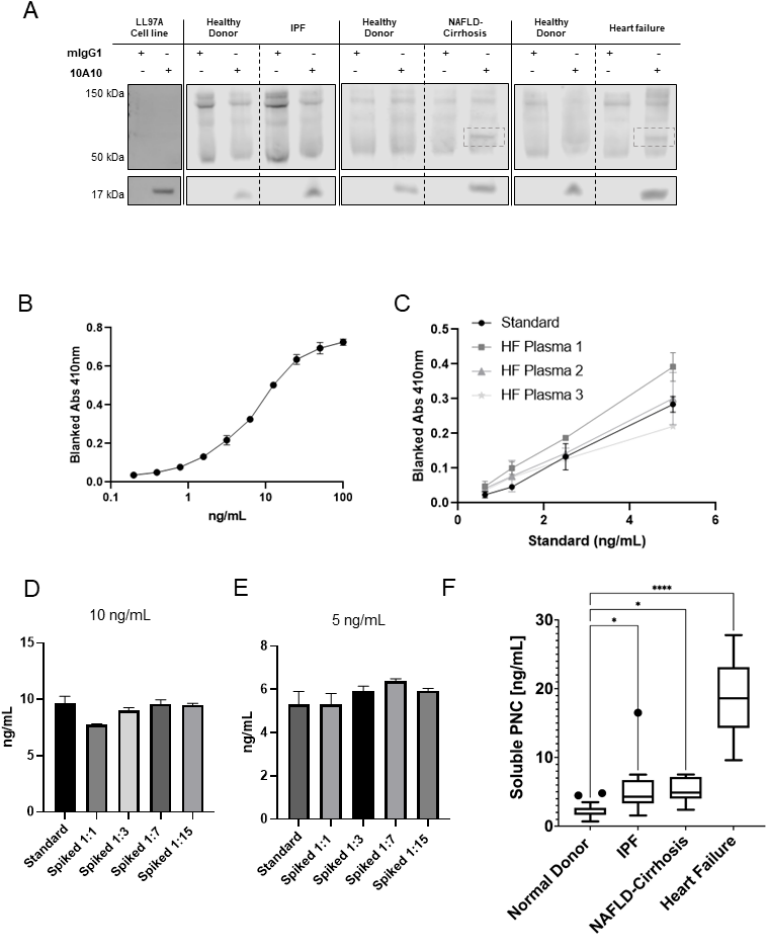
Figure 4. Feasibility and development of a PNC ELISA. ( A ) Soluble PNC product was immunopre- cipitated from LL29 conditioned media and patient plasma from pooled healthy donors, IPF patients, NAFLD-Cirrhosis patients and cardiomyopathy patients using m- α -PNC mAb 10A10 compared to mouse IgG1 isotype control (mIgG1) and immunoblotted. ( B ) Recombinant prodomain analyte was serially diluted in duplicate starting at 100 ng/mL in standard diluent and measured by ELISA to determine the range of the standard. ( C ) Linearity of endogenous analyte was measured. Plasma from patients with heart failure was serially diluted 1:3, 1:7, 1:15, 1:31 in standard diluent and sPNC was measured by ELISA in duplicate. All linear regression r 2 values were calculated to be